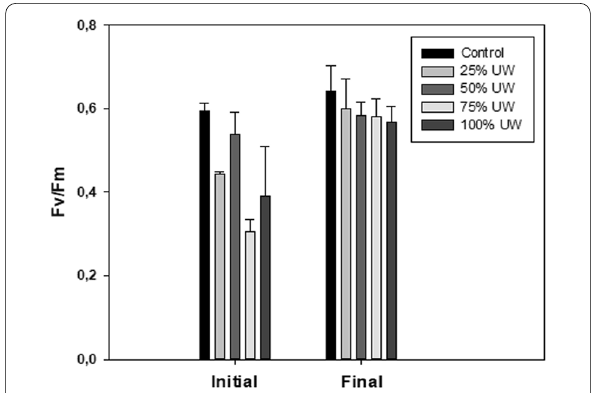
Fig. 6 Initial and final maximum quantum yield (Fv/Fm) for each treatment. Data are expressed as mean